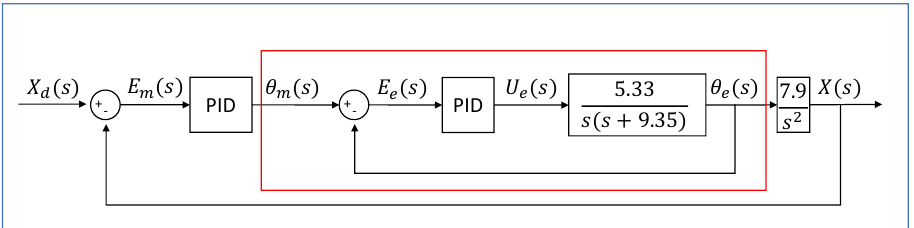
Figure 14. The block diagram of the ball and beam control in closed loop, with the plant constants